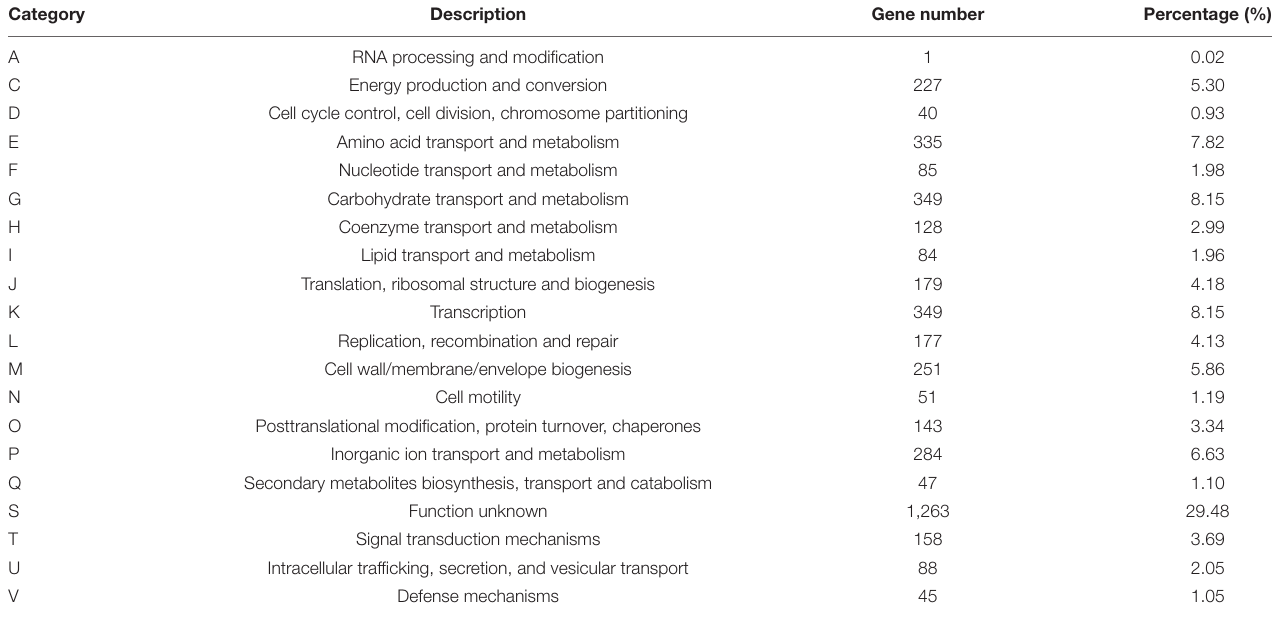
TABLE 2 | COG functional categories of strain Pa82